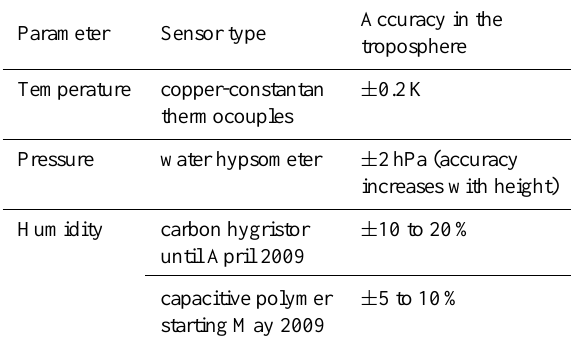
Table 2. Accuracies of the Swiss SRS400 radiosonde sensors.